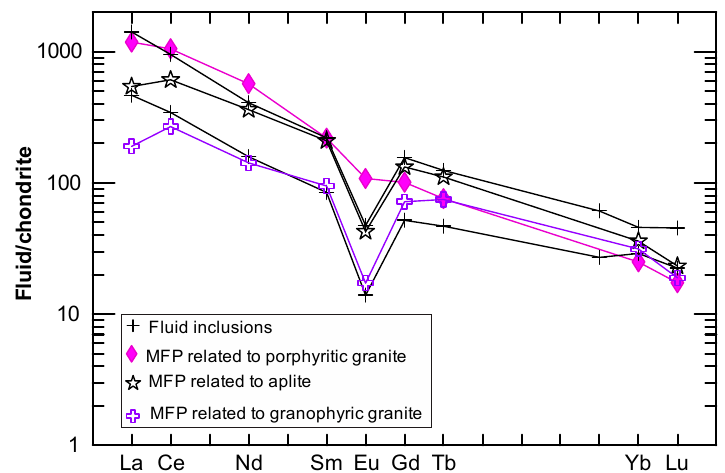
Figure 6. A comparison of chondrite-normalized REE patterns of the fluid inclusions (analyzed by inductively coupled plasma mass spectrometry, or ICP-MS) [6] with calculated magmatic fluid phases (MFP) related to the porphyritic granite (sample A29), the aplite (A17), and the granophyric granite (A12) from the Capitan Pluton, New Mexico, U.S.A. [39] (Supplementary Table S2). The chondrite normalizing values are taken from [38].